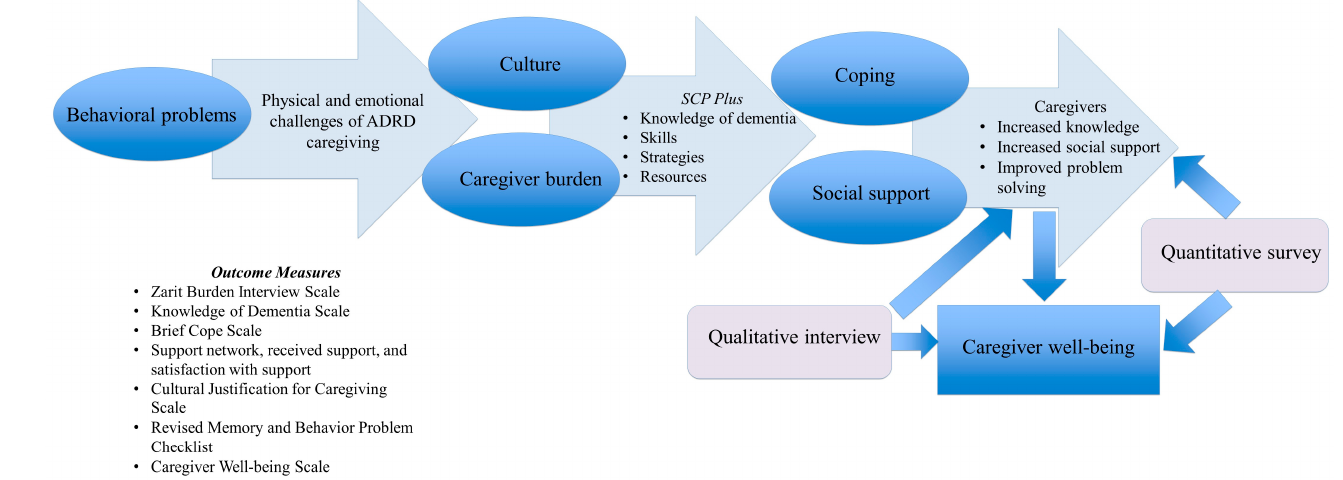
Figure 1. Theoretical Framework.